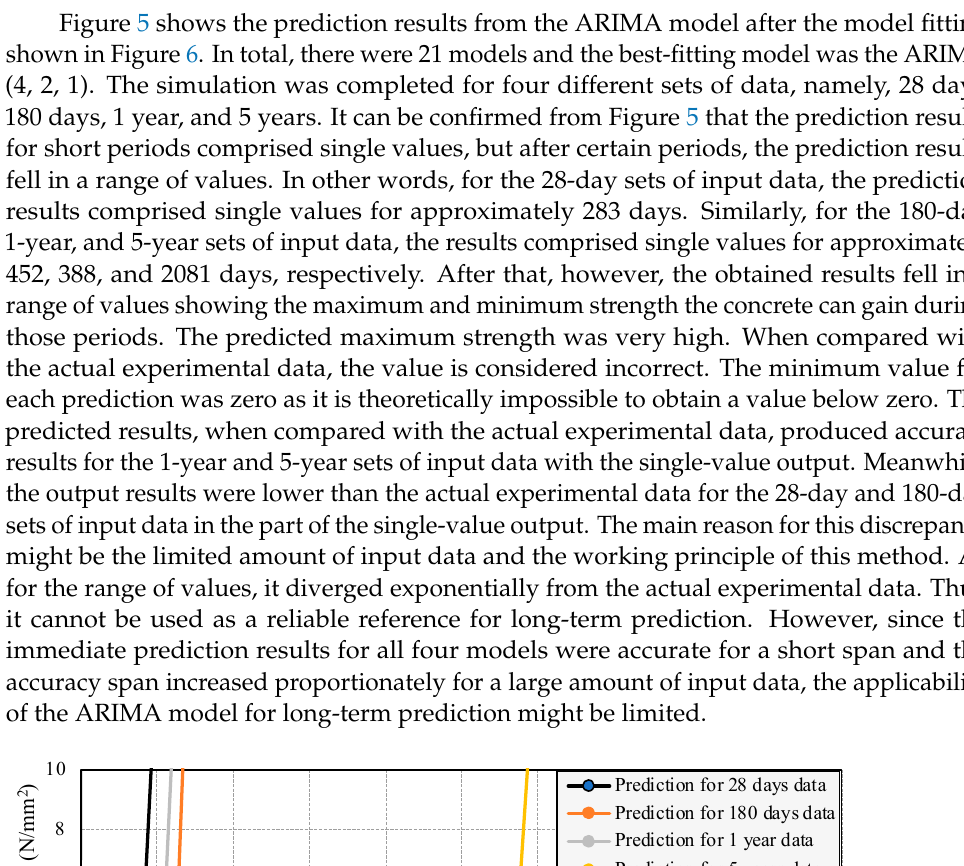
Figure 6. Fitting results of the ARIMA model. 3.3. Prediction Results by SSR Model Figure 7 shows the prediction results by the SSR model for the input data of the ex ‐ perimental compression strength of the GBFS. A simulation was conducted for the sets of input data for 28 days, 180 days, 1 year, and 5 years, respectively, and a prediction was made for the 10 ‐ year time period in each simulation. In this model, the results were out ‐ putted in the form of maximum and minimum values and when compared with the actual strength, the actual strength was found between the predicted values for all cases, which verified the correctness of the prediction. The 5 ‐ year input data produced the most accu ‐ rate results, suggesting a correlation between the amount of input data and accuracy. However, it can be observed that the prediction results for the 28 ‐ day input data were